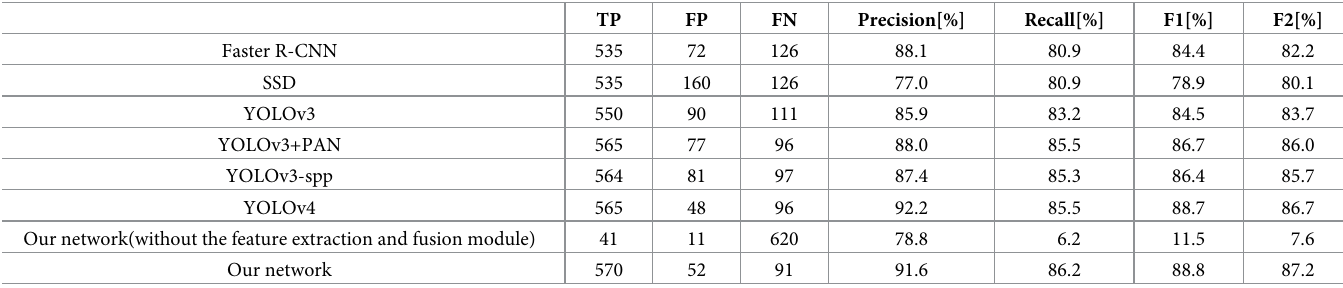
Table 3. Summary of results for gastric polyps